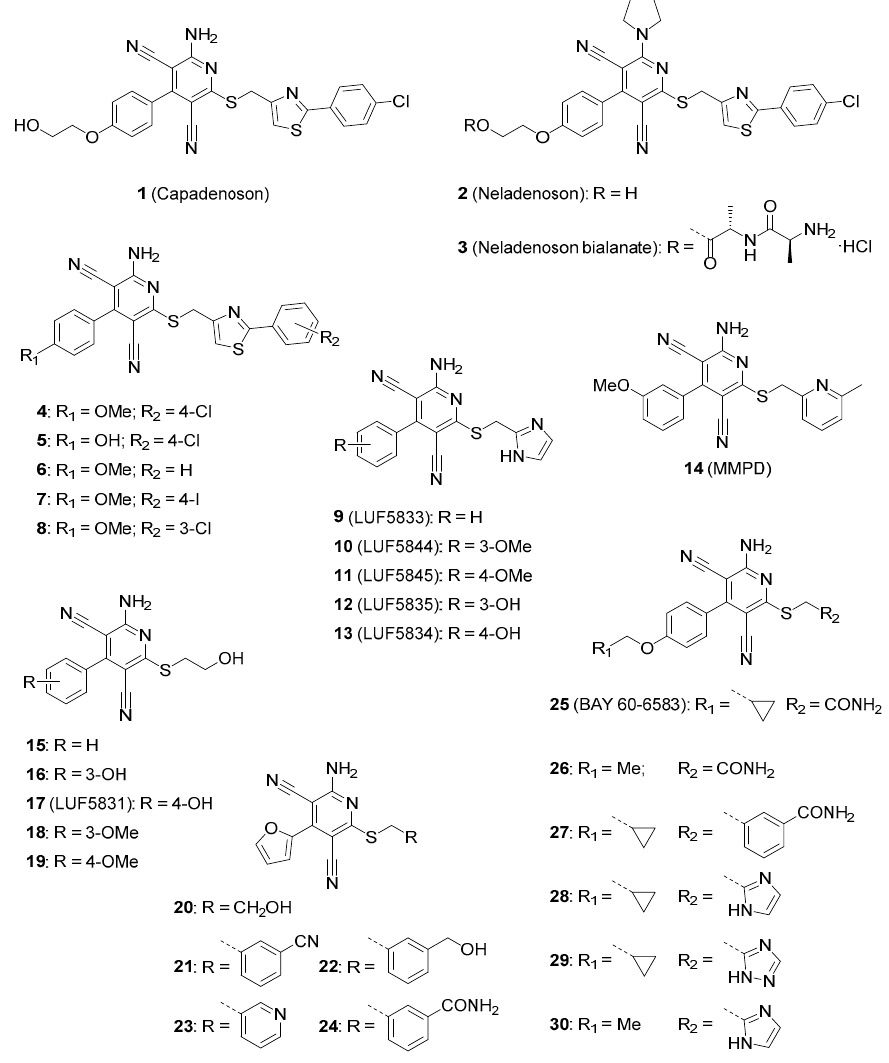
Figure 1. Selected pyridine-based non-nucleoside agonists of the adenosine receptors.